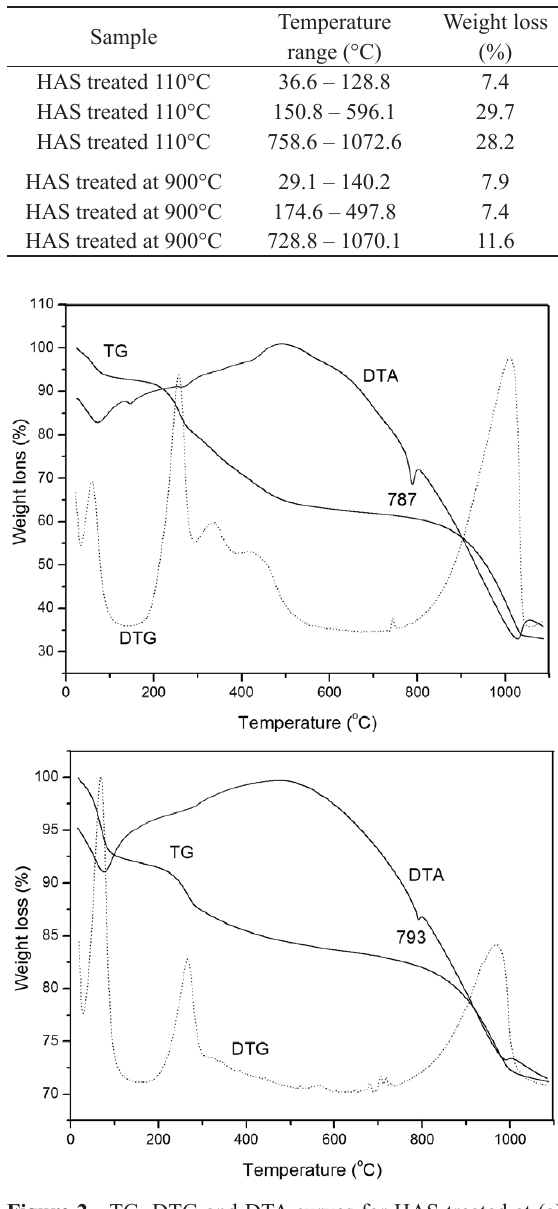
Figure 2 - TG, DTG and DTA curves for HAS treated at (a) 110°C or (b) 900°C after contact with SBF for three